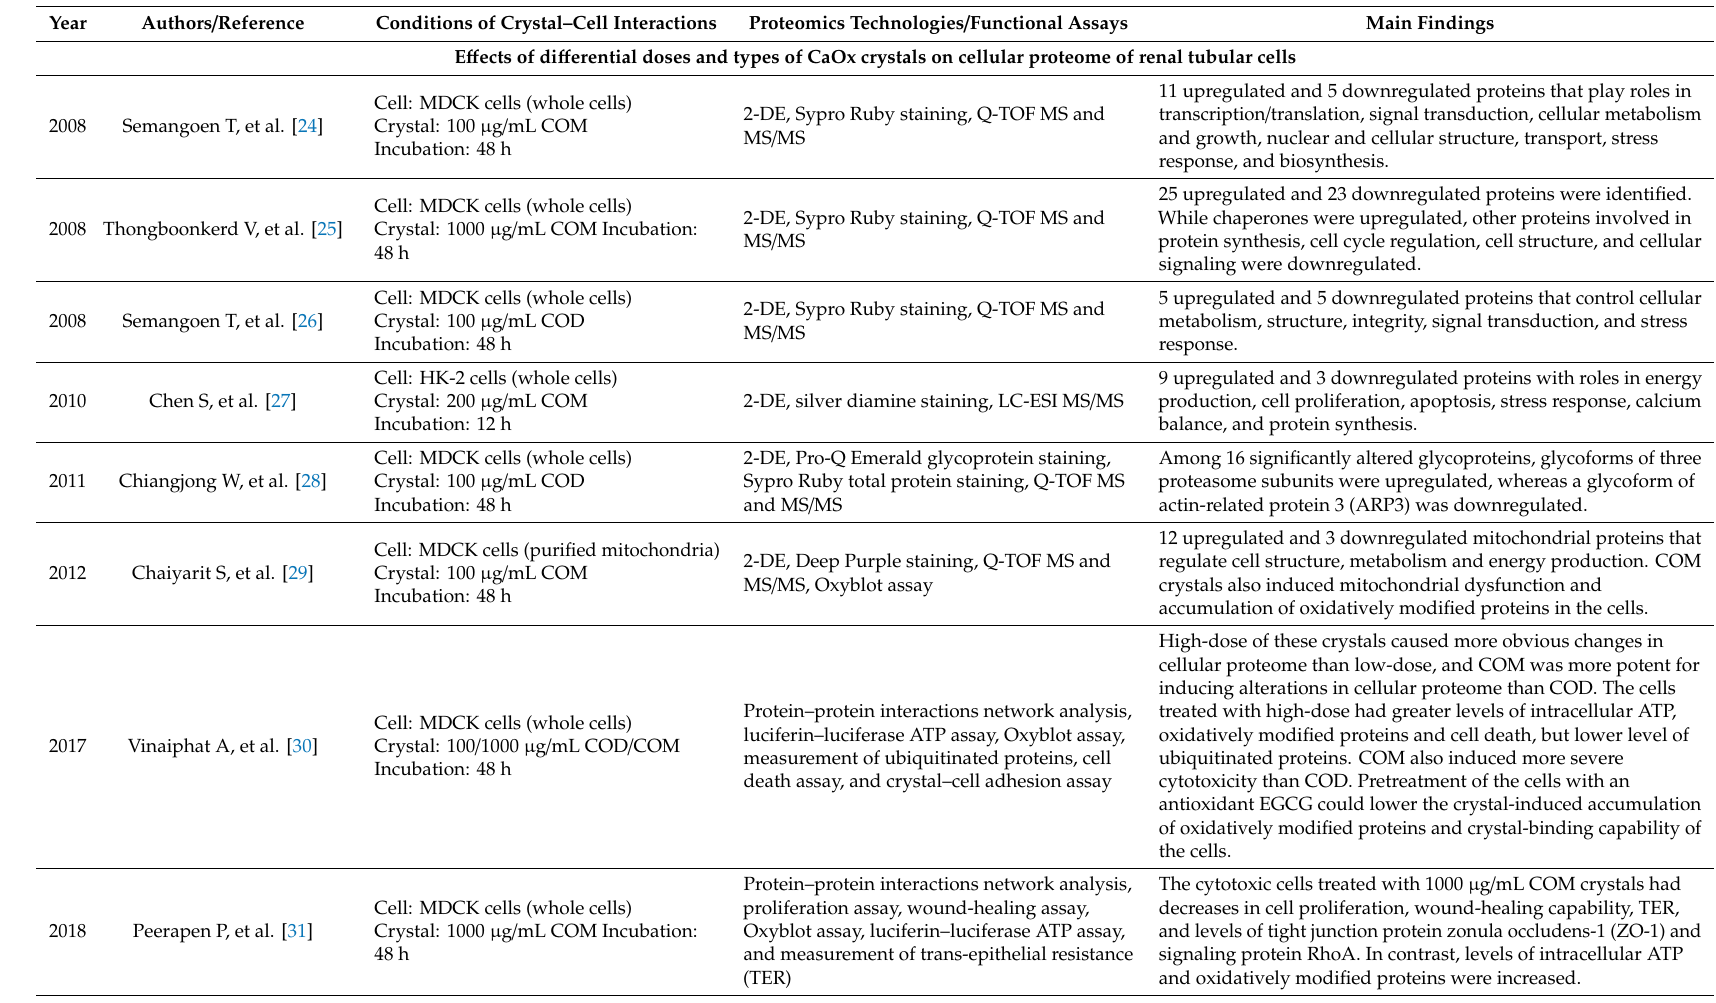
Table 1. Summary of all relevant studies related to proteomics of CaOx crystal–cell